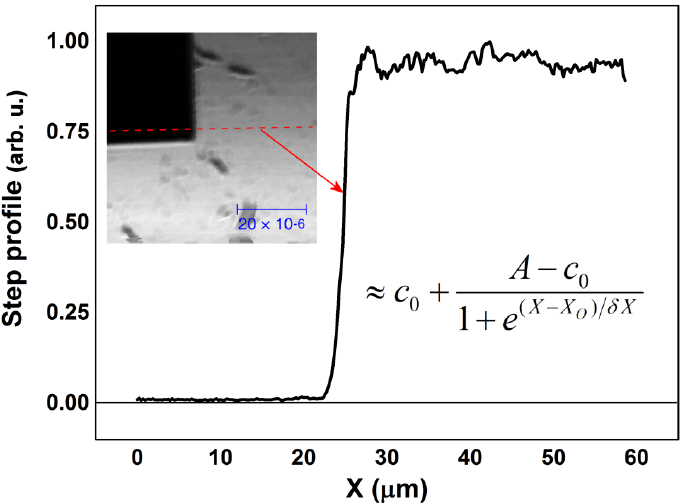
Figure 7. Reflected intensity measured on the edge of the square hole. The extraction region is indicated by the dashed line on the inset image (wavelength 550 nm, lateral size 60 μm).